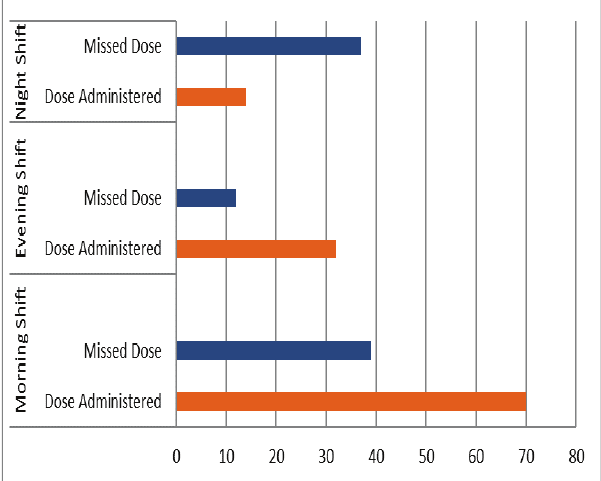
Figure-II: Missed Doses and Doses Administered by Individual Nurses per